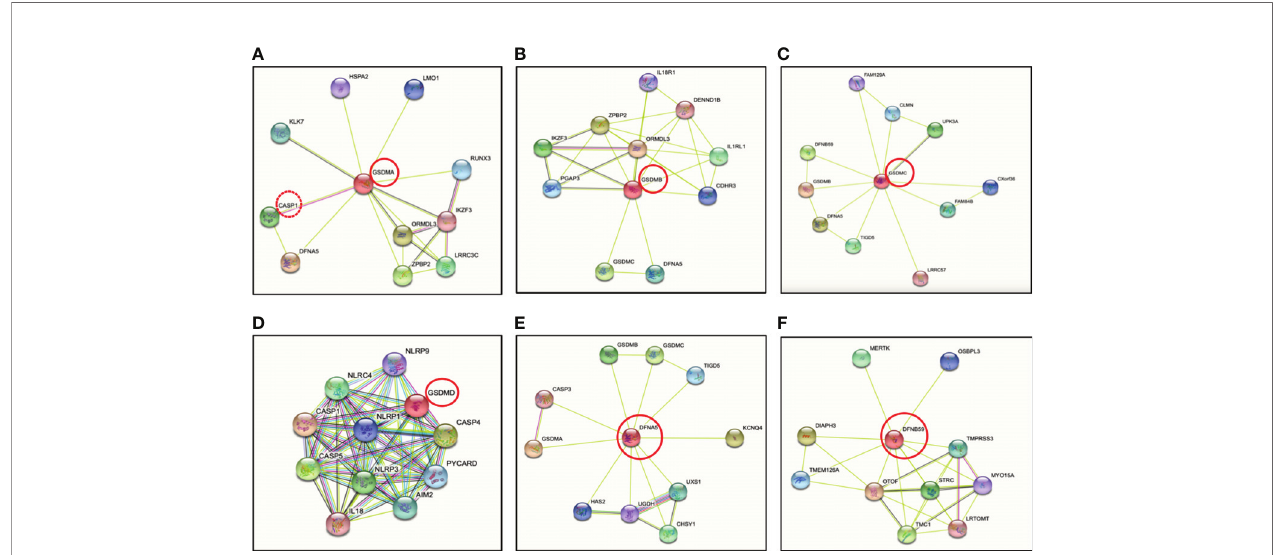
FIGURE 4 | Protein-protein interactions of the human gasdermin family members by STRING analysis. (A) GSDMA is cleaved by caspase-1 with predicted interaction between GSDMA and DFNA5. GSDMA is co-expressed with KLK7, IKZF3 and ORMDL3. (B) GSDMB is co-expressed with ORMDL3 as GSDMA. ORMDL3 is ORM1- like protein 3, a negative regulator of sphingolipid synthesis, which may indirectly regulate endoplasmic reticulum-mediated Ca 2+ signaling. (C) The co-expression of GSDMC is UPK3A or uroplakin-3a, is a component of the asymmetric unit membrane (AUM). UPK3A is a highly specialized biomembrane elaborated by terminally differentiated urothelial cells, that play an important role in preventing bacterial adherence. (D) GSDMD is essential effector of NLRP3 in fl ammasome-dependent caspase-1 activation and IL-1 b /IL-18 secretion in response to noncanonical activators, including UVB radiation, cholera enterotoxin subunit B and cytosolic LPS. (E) GSDME or nonsyndromic hearing impairment protein 5 (DFNA5) plays a role in the TP53-regulated cellular response to DNA damage probably by cooperating with TP53, which is known to activate the transcription of numerous tumor suppressors and activators of apoptosis. In addition to pyroptotic activity, GSDME interacts with caspase-3/7 to trigger apoptosis by targeting mitochondria, but is more strongly implicated in tumor suppression. (F) Protein-protein interaction analysis shows no direct connection between DFNB59 and other GSDMs. Otoferlin (OTOF) is a key Ca 2+ sensor involved in Ca 2+ dependent SNARE-mediated exocytosis. Possible interaction between DFNB59 and OTOF suggests DFNB59 might be involved in vesicle transportation but requires further con fi rmation.